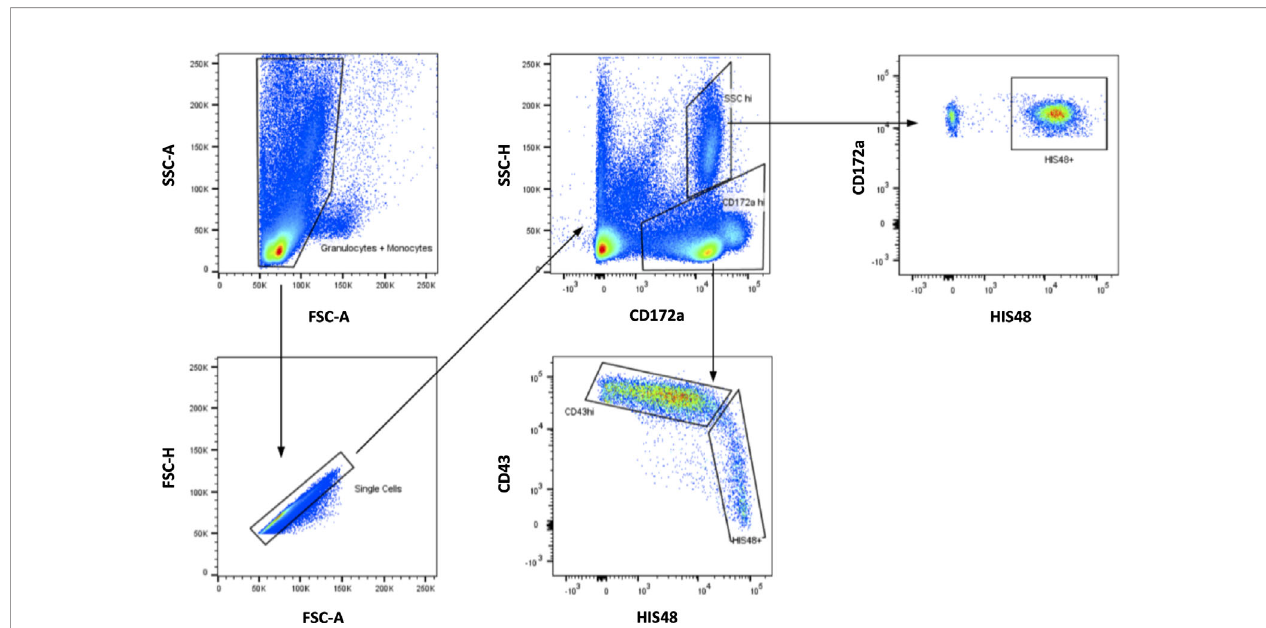
FIGURE 2 | Gating strategy for rat monocytes. After initial visualization of the cells based on SSC and FSC, monocytes were detected among CD172a + cells. Within this gate, smaller CD43 ++ HIS48 low monocytes and larger CD43 low HIS48 ++ monocytes could be